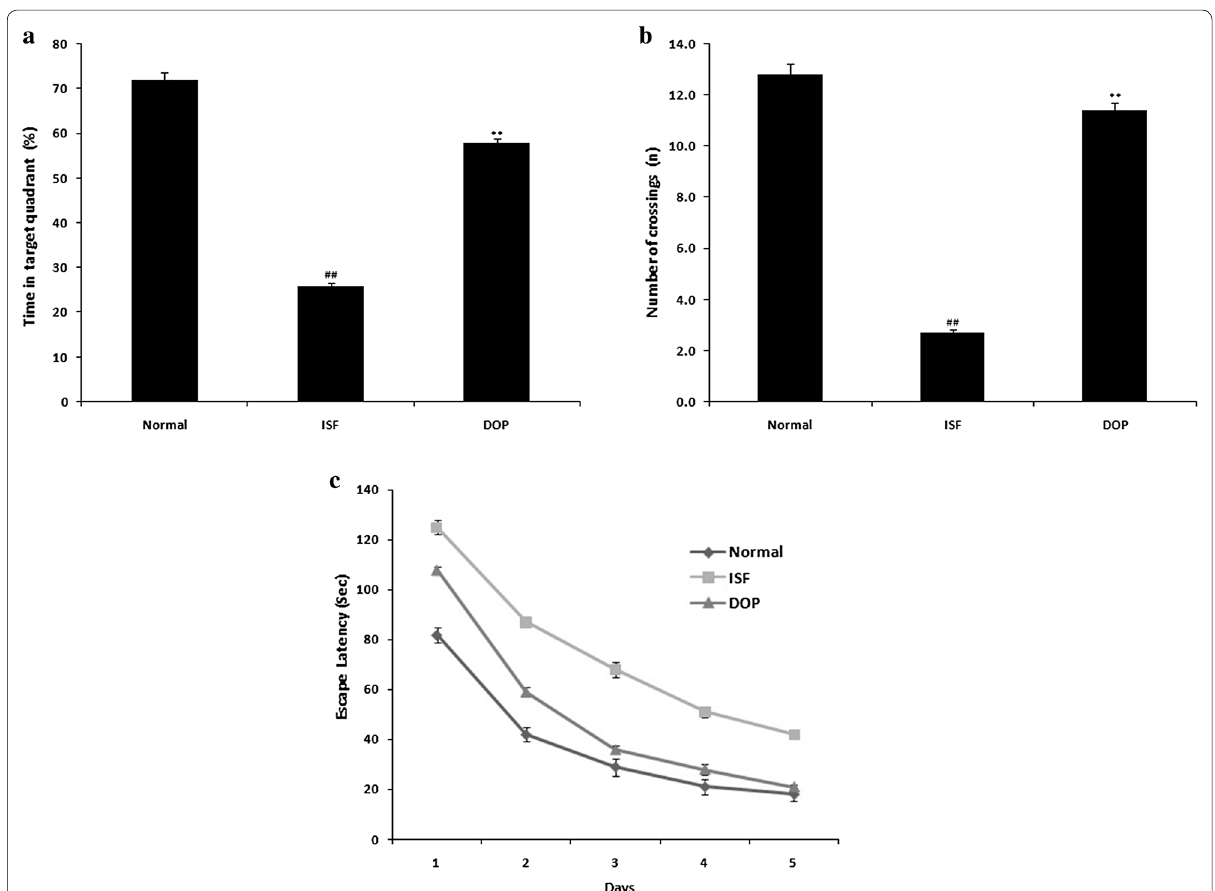
Fig. 1 Desoxyrhapontigenin ameliorates the cognitive function of rats with anaesthesia-induced neuronal injury. a Time in target quadrant (%). b Number of crossings (n). c Escape latency(s). Mean